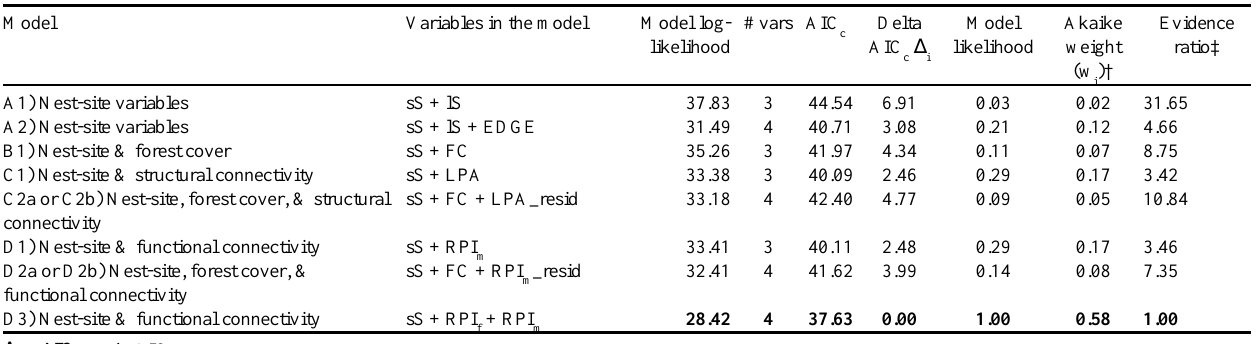
Table 3 . Model selection for models of S. citrina nest occurrence in 2004 (southern Ontario) with nest-site variables and site- context measures of forest cover, and structural OR graph-based functional connectivity. Variable codes and transformations as in Table 1. Further model details, e.g., parameter estimates, standard errors, odds ratios, can be found in Table 2.